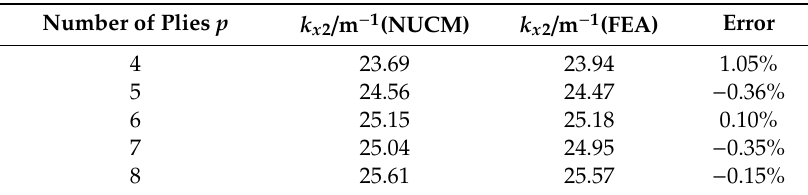
Table 3. Principal curvature of anti-symmetric cylindrical shells with different number of plies from analytical model and simulation.